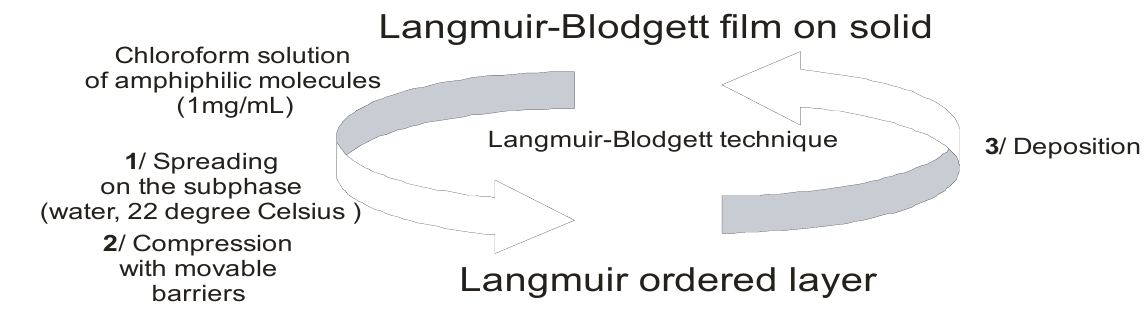
Figure 10. Simplified scheme of preparation LB films.